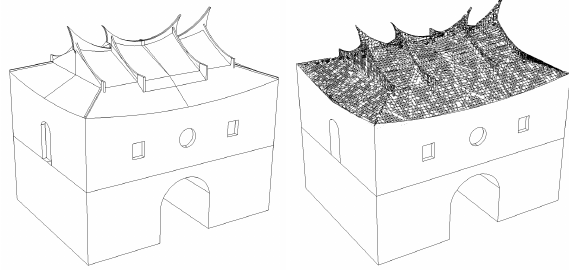
Figure 7. Polyhedral (left) and hybrid (right) models of the Taipei North Gate providing different levels of